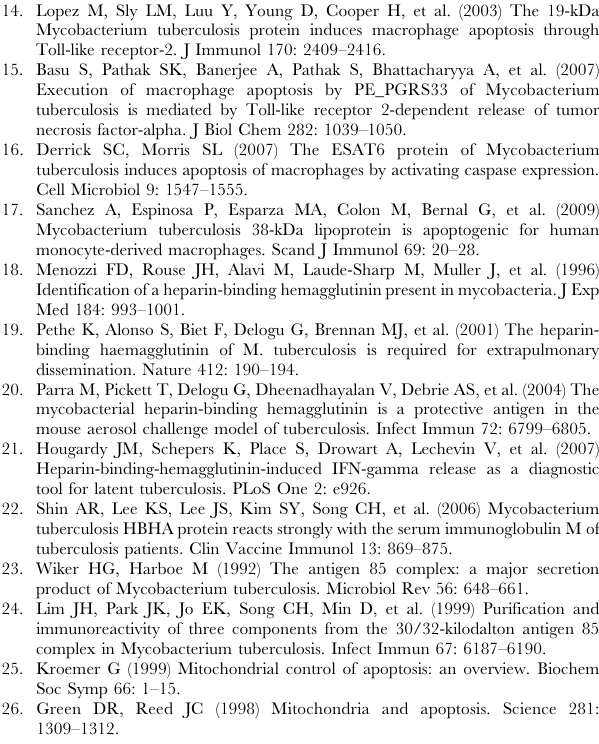
Figure S1 Recombinant HBHA protein did not increase LDH release in RAW 264.7 cells. RAW 264.7 cells were incubated with the indicated concentrations of HBHA for 48 h. And then LDH release was measured by Cytotoxicity Detection Kit. Positive control was generated by treating cells with 1% Triton X-100 (TX-100) for 1 h prior to the onset of the assay. (TIF) Figure S2 DNA fragmentation and LDH release in BMDMs infected with M. tuberculosis H37Rv wild type and mutant disrupted in hbhA . BMDMs were infected with M. tuberculosis wild-type (WT) or mutant (Mu) at indicated MOIs for 24 h. DNA fragmentation (A) and LDH release (B) were measured as described in Figure 1 and Supplemental Figure S1, respectively. *** P , 0.001 cells infected with M. tuberculosis WT versus with mutant strain at an MOI of 5. ** P , 0.01 cells infected with M. tuberculosis WT versus with mutant strain at an MOI of 10.